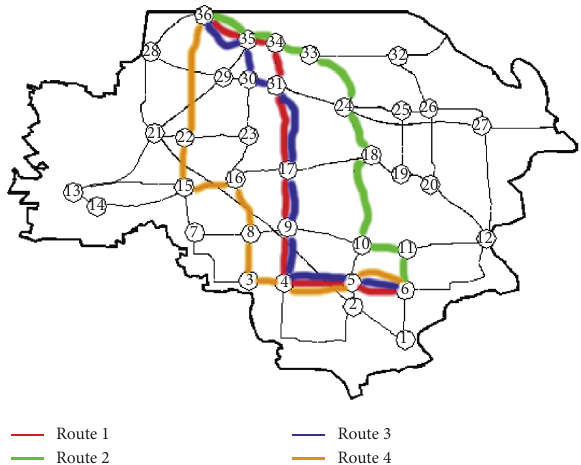
8: Four paths in the set of the nondominated solution.